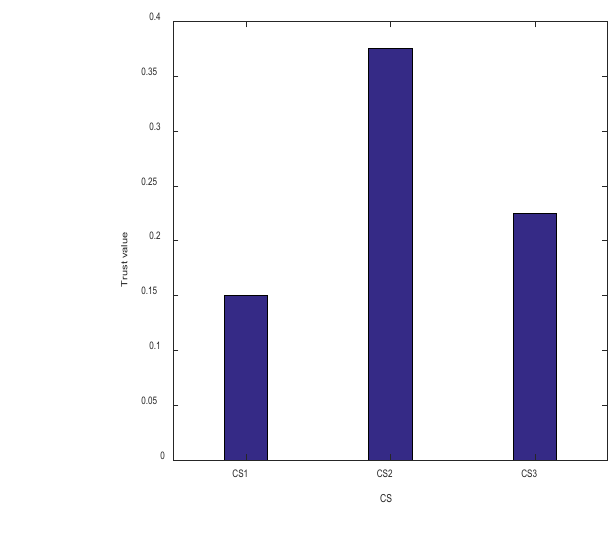
Fig 9 PCC of CS 1-3 Fig 10 Trust value establishment of three different cloud services